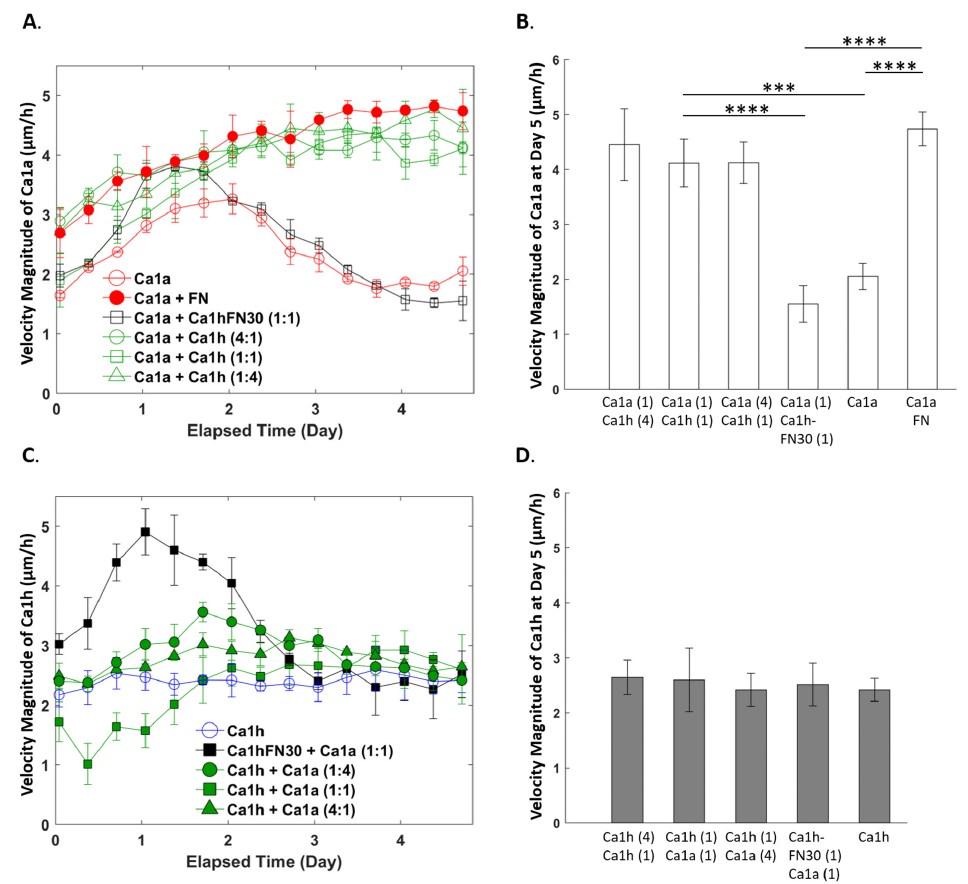
Figure 2. Velocity of Ca1a and Ca1h cells in mono-culture and co-culture within the microfluidic chamber. ( A ) Mean velocity magnitude of Ca1a and ( B ) at the terminal time point. ( C ) Mean velocity magnitude of Ca1h cells across culture conditions and ( D ) at the terminal time point. p -values are denoted with asterisks (*) as follows: ***: significant at p < 0.001, and ****: significant at p < 0.0001.